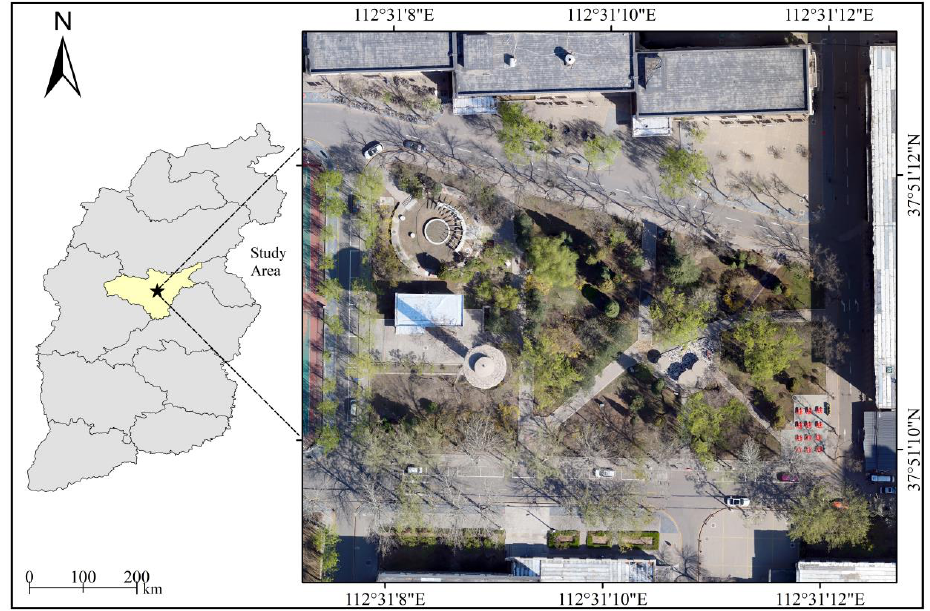
Figure 1. Location of the study area as marked by a star.